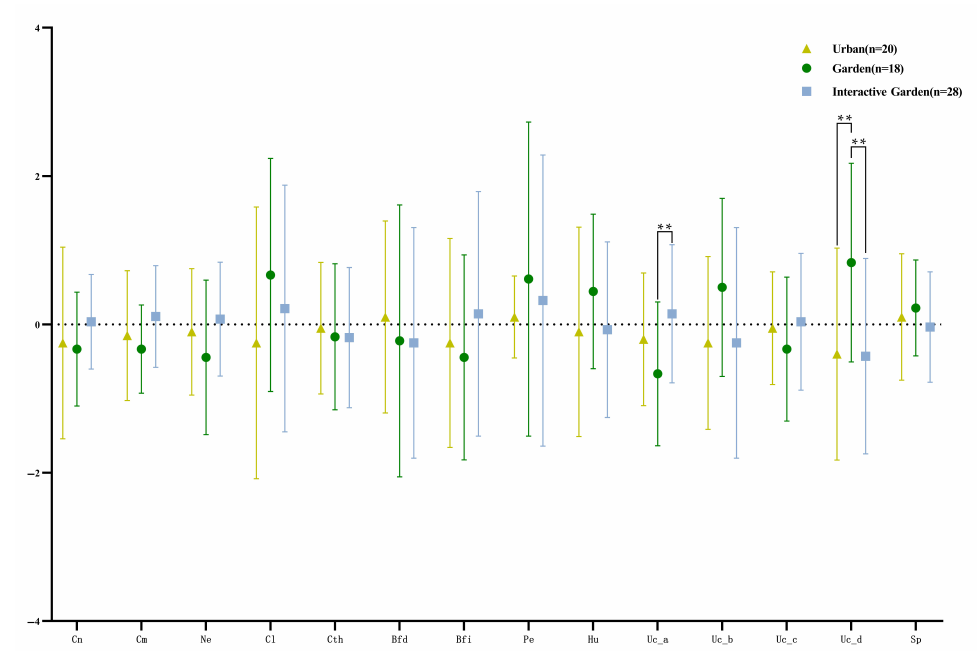
Figure 7. Descriptive statistical results of the TCT-DP score changes for the three scenes in each dimension. Note: ** represents p < 0.01.